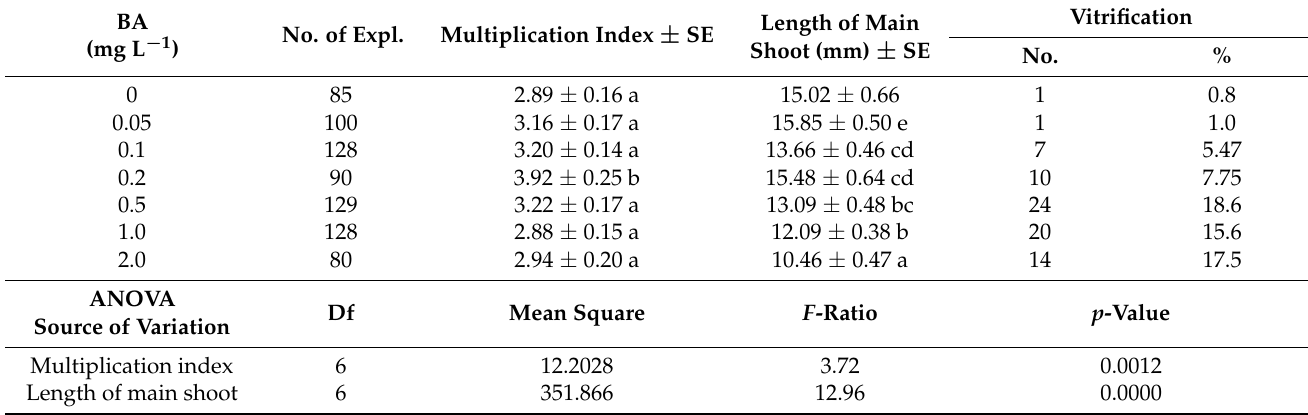
Table 2. Effect of increasing concentrations (0–2.0 mg L − 1 ) of BA on shoot multiplication, the length of the main shoot and vitrification incidence of G. lutescens line 5. Values represent the means ± SE from 3–4 experiments with 25–40 samples per treatment ( n = 80–129). Data were analyzed by one-way ANOVA analysis. Within each column means followed by different letters are significantly different according to Fisher’s LSD test at p ≤ 0.05. Results were scored after 35 days. Multiplication index—main shoot + axillary